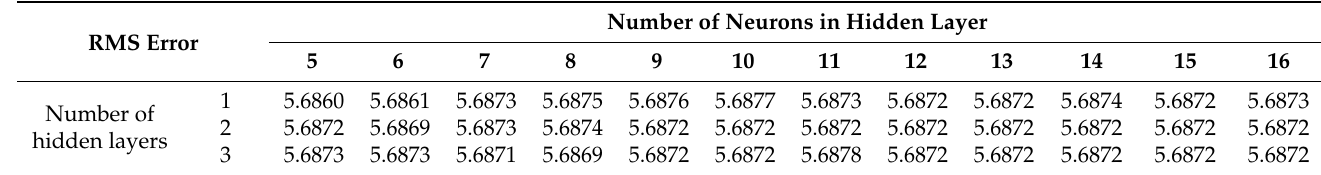
Table 13. RMS error for active power loss estimation for IEEE-34 bus system (case 1).